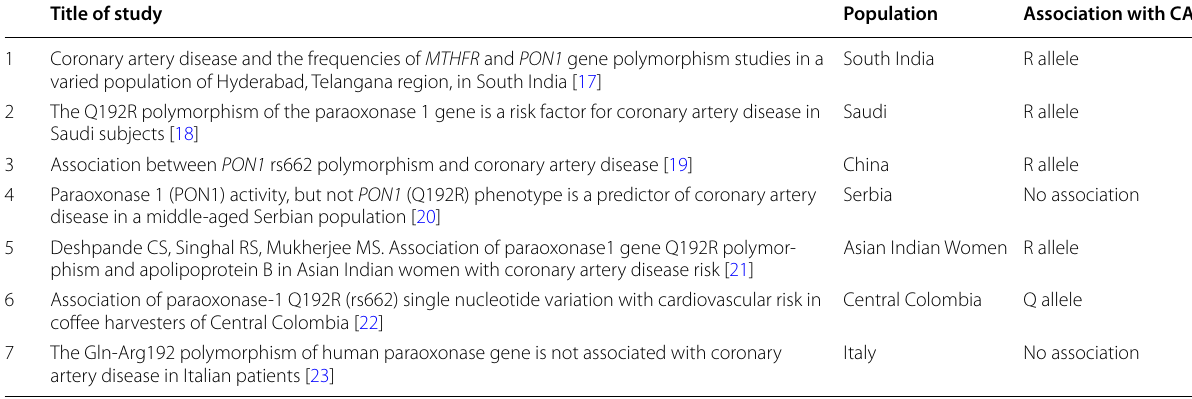
Table 8 Studies showing the association of PON1 Q192R polymorphism in distinct ethnic